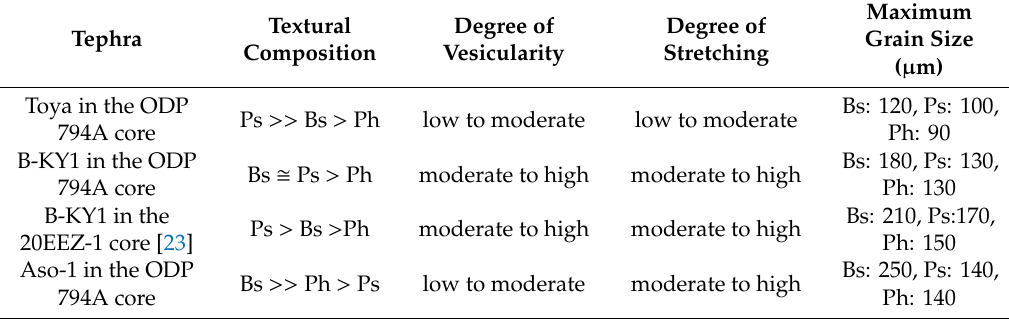
Table 1. Textural characteristics of the three tephras in the ODP 794A core and B-KY1 tephra in